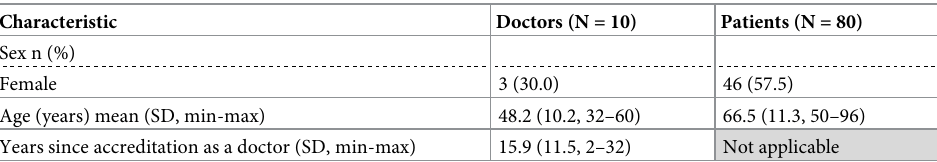
Table 2. Adapted descriptive characteristics of physicians and patients included in the final data set